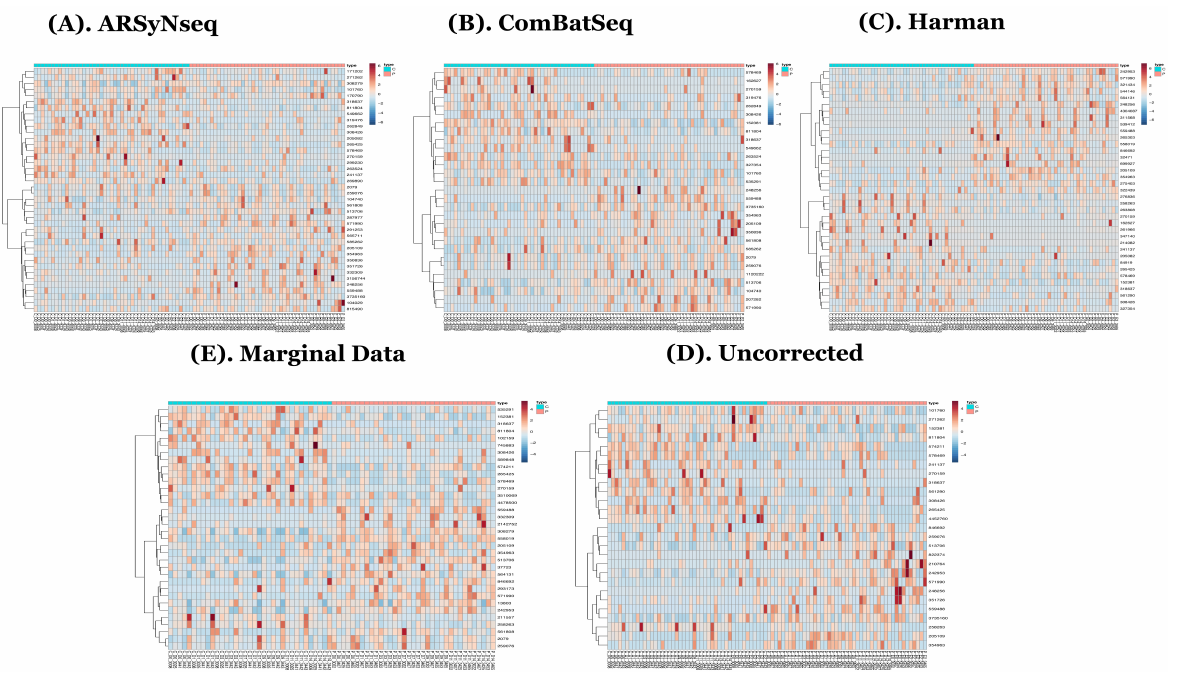
Figure 3. ( A – E ) show heatmaps generated from the MicrobiomeAnalyst [27,28] at taxonomy feature levels from core intersection sets detected by multiple longitudinal differential abundance test meth- ods in 5 different types of batch handling procedures (ARSyNseq, ComBatSeq, Harman, Uncorrected, and Marginal Data in clockwise from top-left) after filtering out low abundant features via default criteria in MicrobiomeAnalyst [27,28] from Figure 2A–E. Note that type C and P represent a control and target treatment group, respectively.